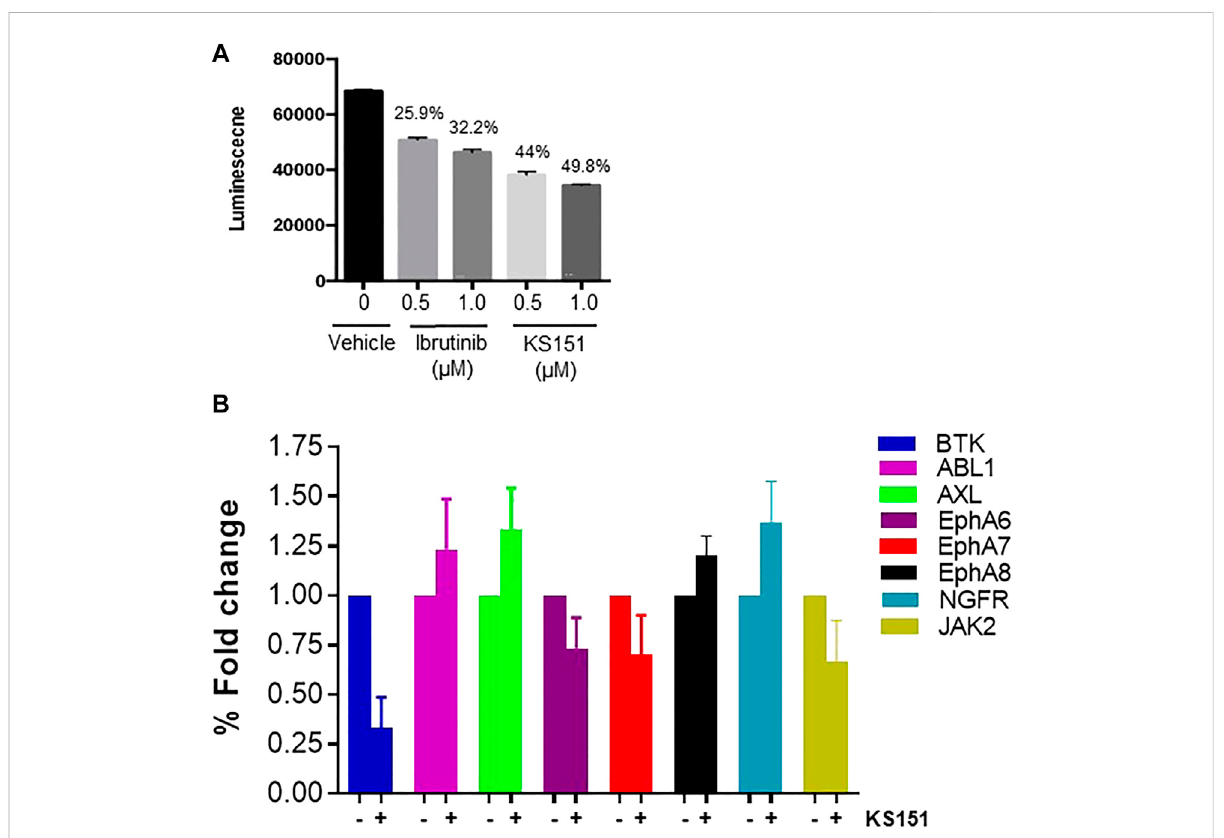
FIGURE 3 KS151 inhibits the in vitro BTK kinase activities and speci fi c to BTK. (A) , KS151 suppresses in vitro kinase activities in a dose-dependent manner. Different doses of KS151 were used to determine the kinase inhibitory response. Values written on top of bars indicate the percentage inhibition of kinase activities. (B) the speci fi city of KS151 was assessed by a semi-quantitative, sandwich-based array for 71-tyrosine kinase phosphorylation signatures. The RayBio Human RTK Phosphorylation Antibody Array kit was used to investigate the effect of KS151 on various kinases. Data represents the response of KS151 on various